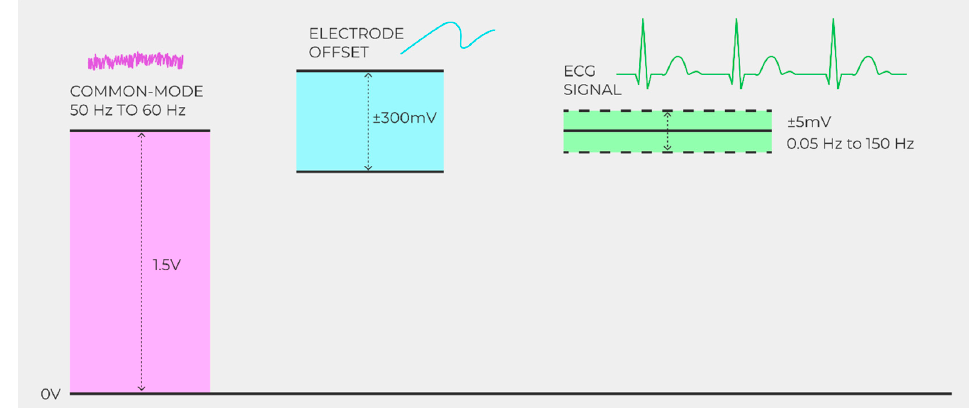
Figure 1. ECG signal levels.